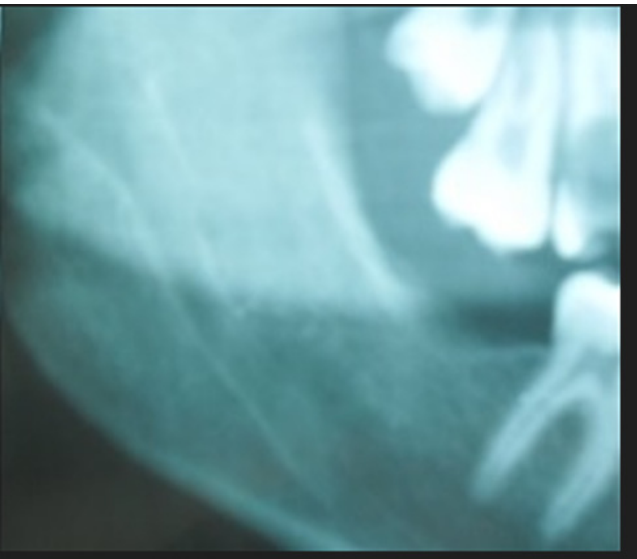
Figure 9. Enlarged visualization of the entirely healed bony defect in the right mandibular angle. Courtesy of Dr. W. Pawlak.